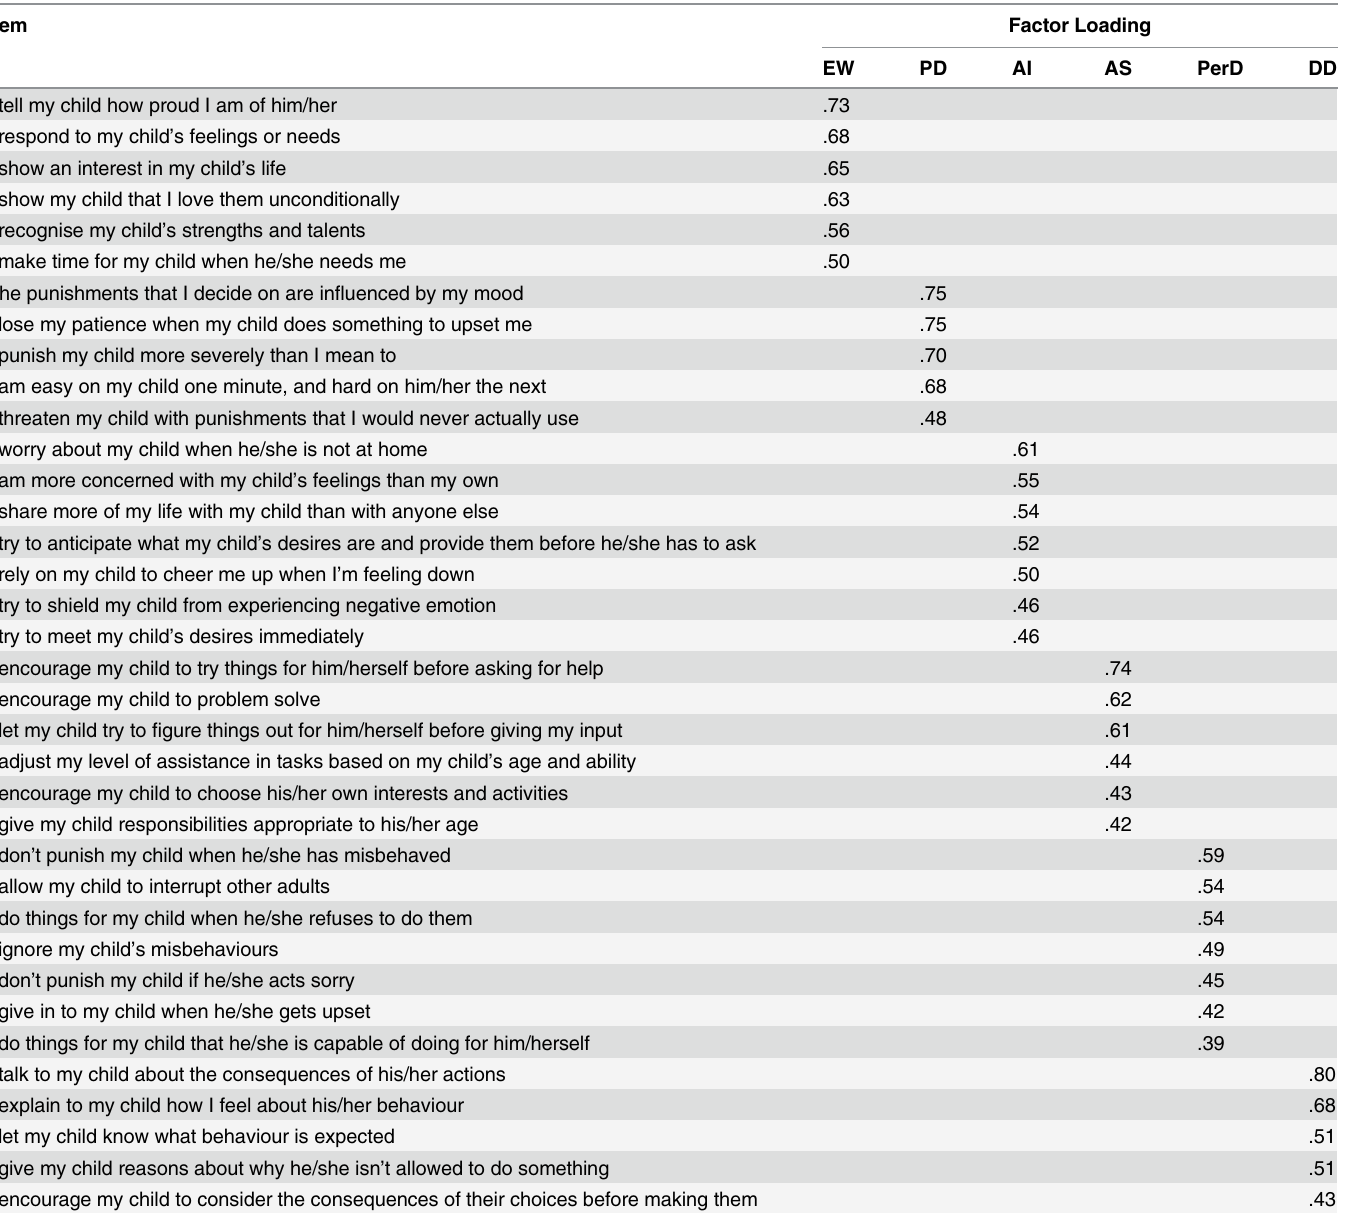
Table 2. Final Pattern Factor Loading Matrix for